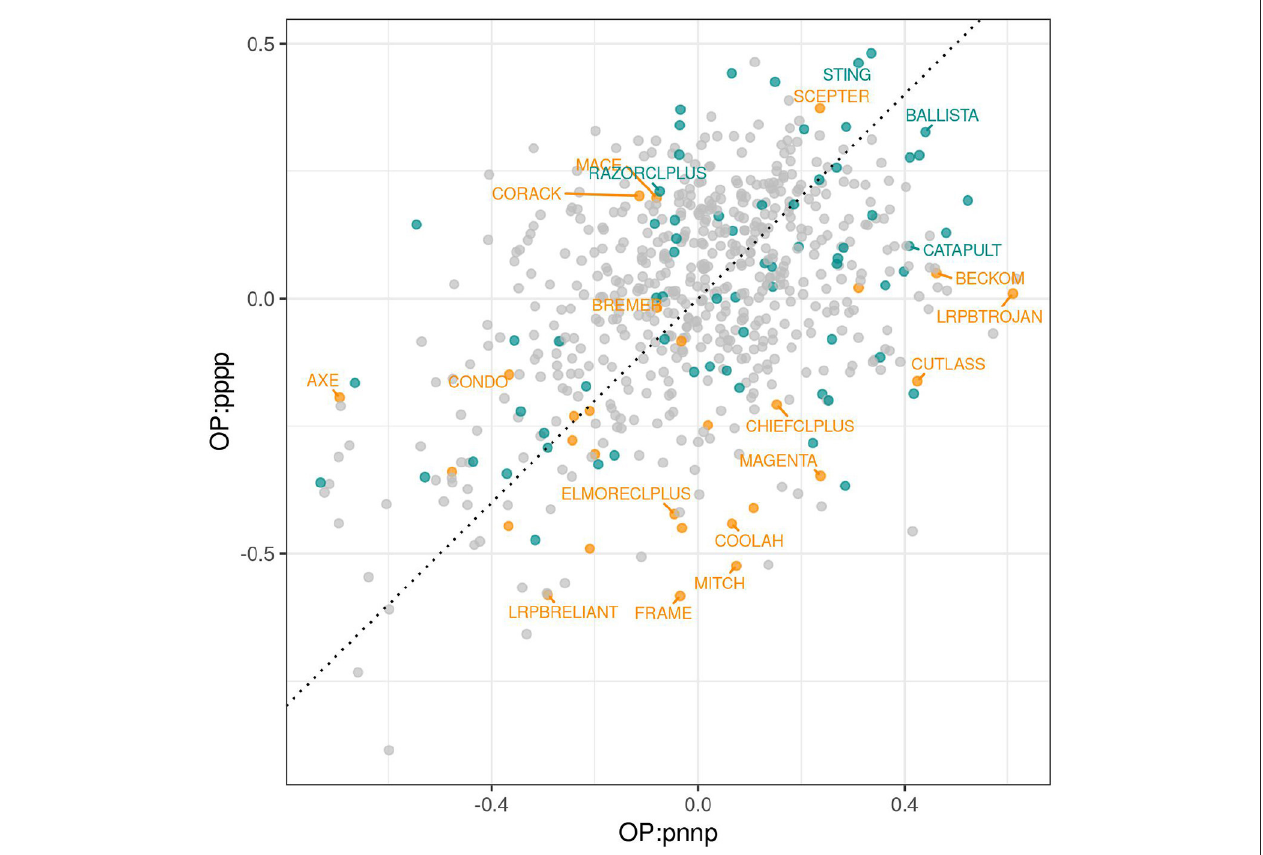
FIGURE 5 | iClassOP for iClasses “pppp” and “pnnp” for all varieties. Points are colored orange (check varieties), blue (test varieties of interest) or gray (remaining test varieties). Selected check varieties have been labeled as have four test varieties that have since been released commercially.